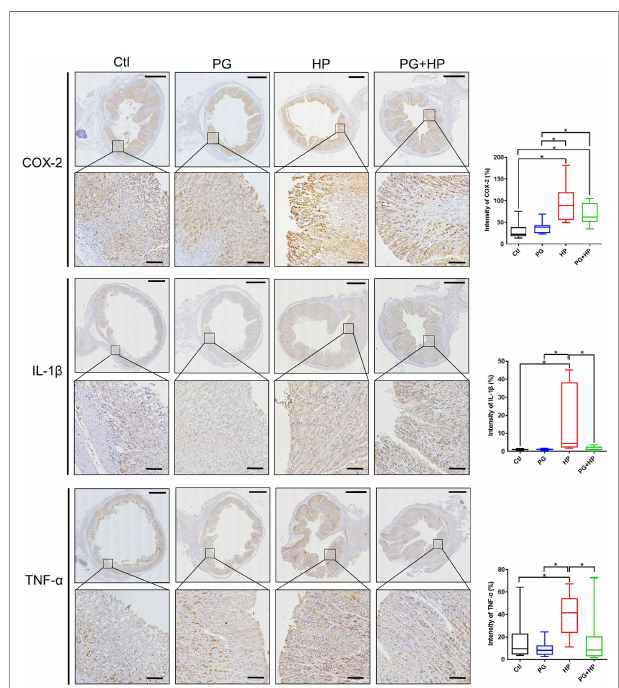
FIGURE 9 | P. goldsteinii MTS01 mitigates H. pylori -induced gastric in fl ammation. Mouse gastric tissues were subjected to IHC staining with speci fi c antibodies against COX-2, IL-1 b , and TNF- a (original magni fi cation: 200×). The magni fi ed images are displayed below each cropped area. Scale in each panel, 1000 m m, and in each magni fi ed image, 100 m m. The intensity of COX-2, IL-1 b , and TNF- a expression for IHC staining in gastric tissues are shown in the right panels. "*" indicated P <